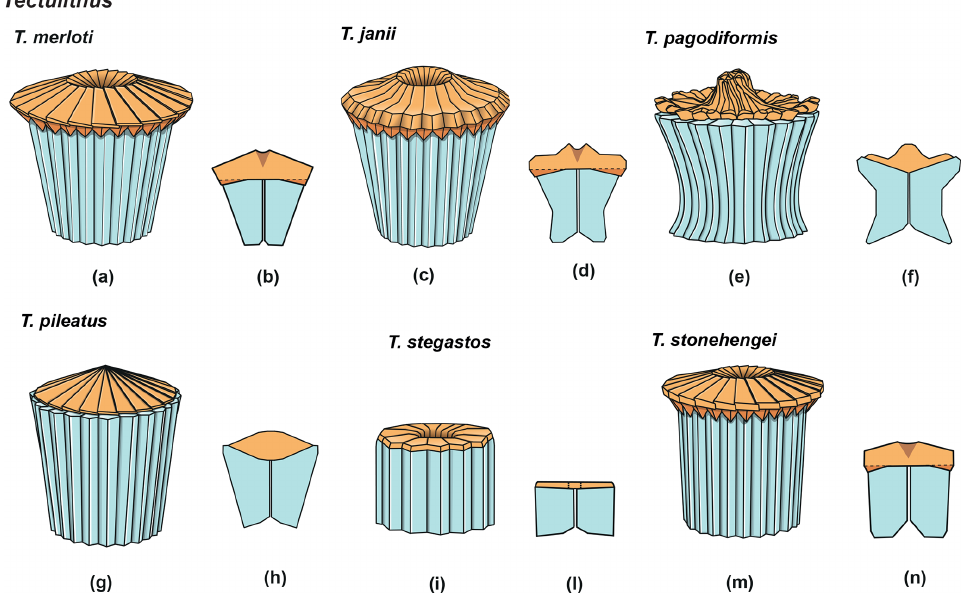
Figure 20. Overview of Tectulithus column (light blue) and tectum (orange). (a) Schematic drawing of the type species T. merloti . (b) Schematic cross section of T. merloti . (c) Schematic drawing of T. janii . (d) Schematic cross section of T. janii . (e) Schematic draw- ing of T. pagodiformis . (f) Schematic cross section of T. pagodiformis . (g) Schematic drawing of T. pileatus . (h) Schematic cross section of T. pileatus . (i) Schematic drawing of T. stegastos . (l) Schematic cross section of T. stegastos . (m) Schematic drawing of T. stonehengei . (n) Schematic cross section of T. stonehengei